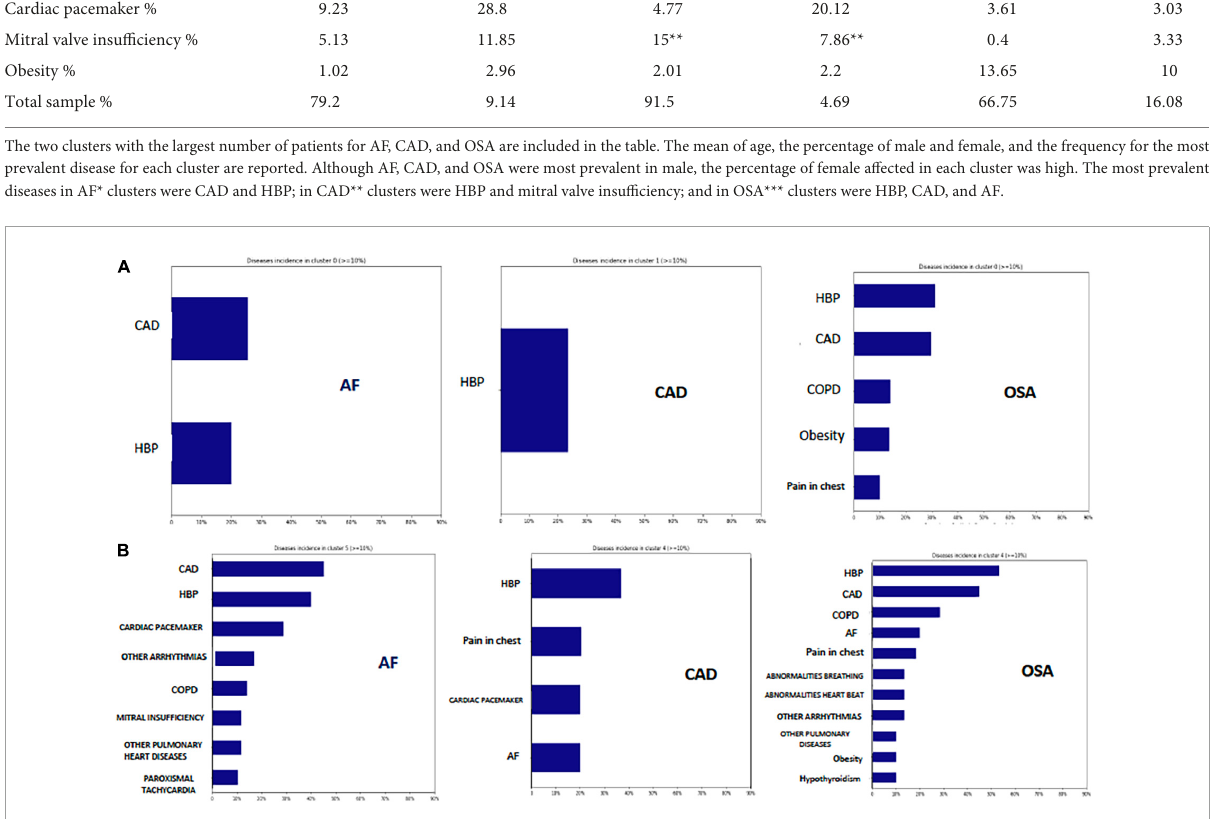
Subsequently, patients with CAD develop AF earlier when